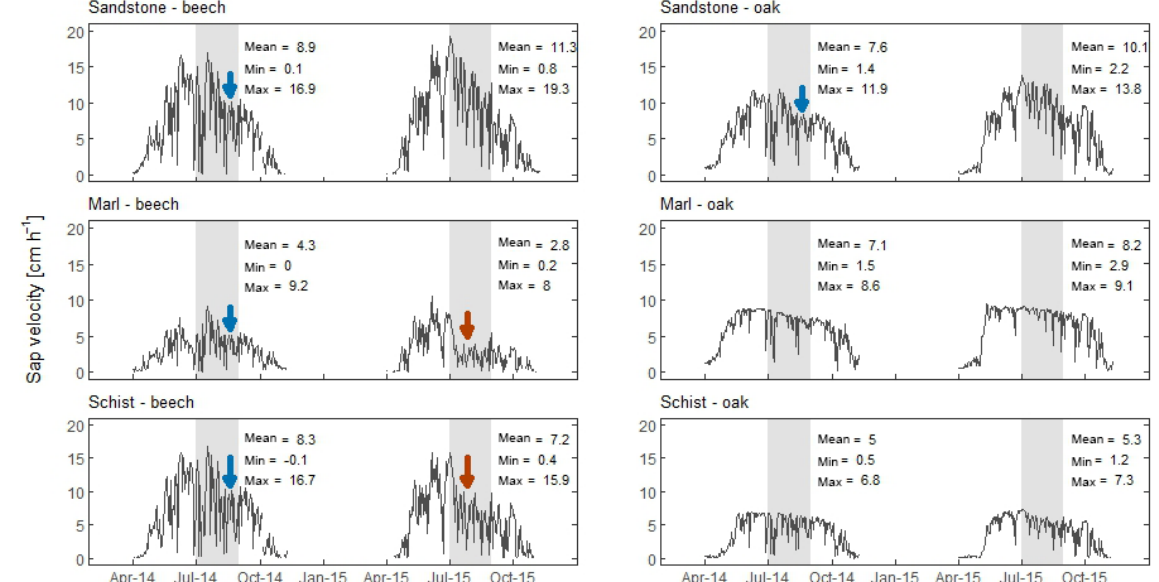
Figure 4. Mean daily sap velocity for beech and oak trees in the three different geologies. The drop in sap velocity in August 2014 (blue arrow) is related to a lower incoming radiation, while the drop in August 2015 (red arrow) is not related to a lower incoming radiation, but falls into a period of below-average precipitation and low soil moisture content. The min, mean, and max values are calculated for July and August in both years, indicated by the grey box.